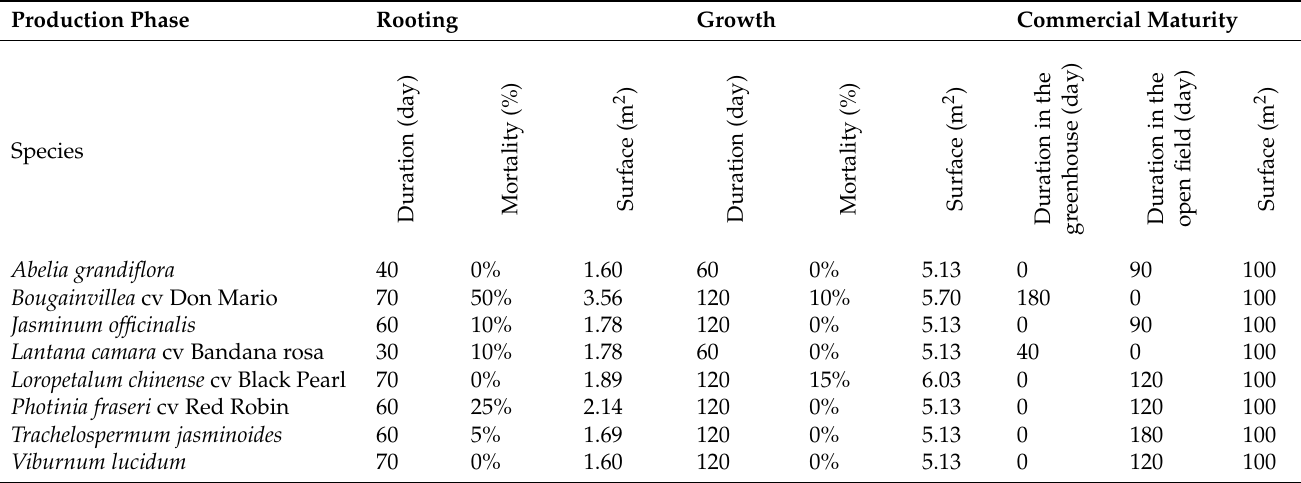
Table 1. Technical parameters used to calibrate the number of inputs to produce 1000 potted plants through the conventional ornamental production model